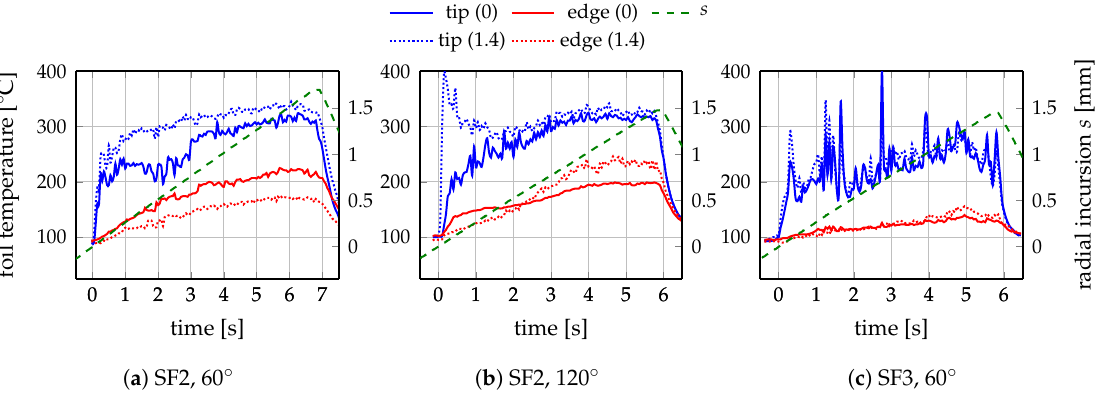
Figure 8. Maximum tip and edge foil temperatures extracted from the IR thermo camera images over time, both in the contact zone (0) and 1.4mm away from the contact zone (1.4) in the perpendicular direction.